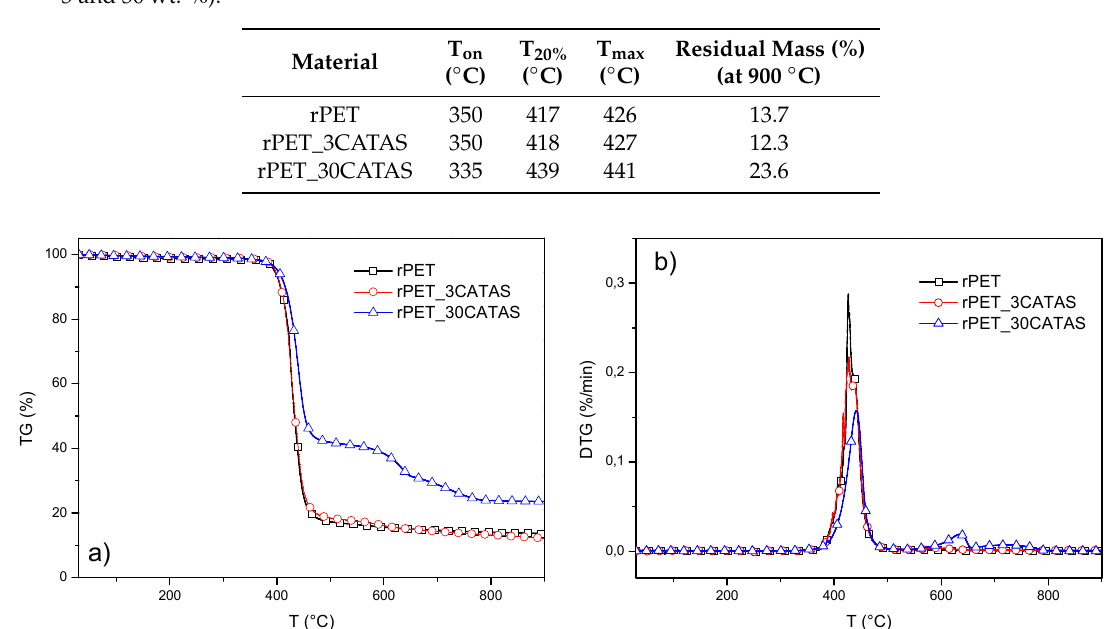
Table 4. TGA parameters of rPET_CATAS nanocomposites at three representative loading levels (0, 3 and 30 wt. %).